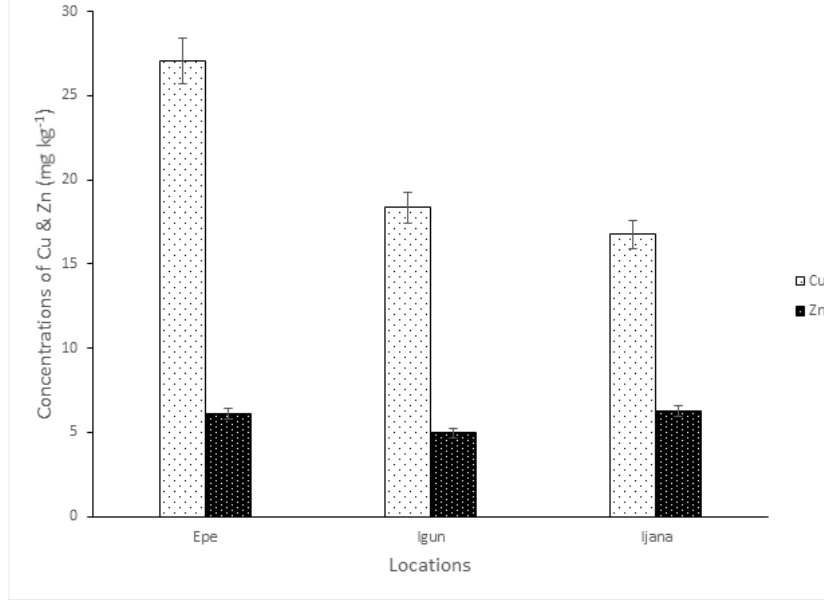
Figure 2: Concentrations of heavy metals (As, Cd, Co, Cr, Ni & Pb) in tomato at Epe, Igun and Ijana sites